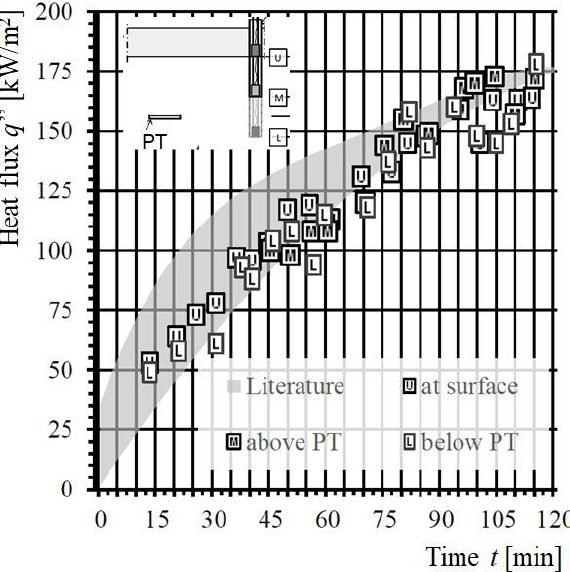
Figure 4: Measurements of the HFS at the positions “Upper” literature